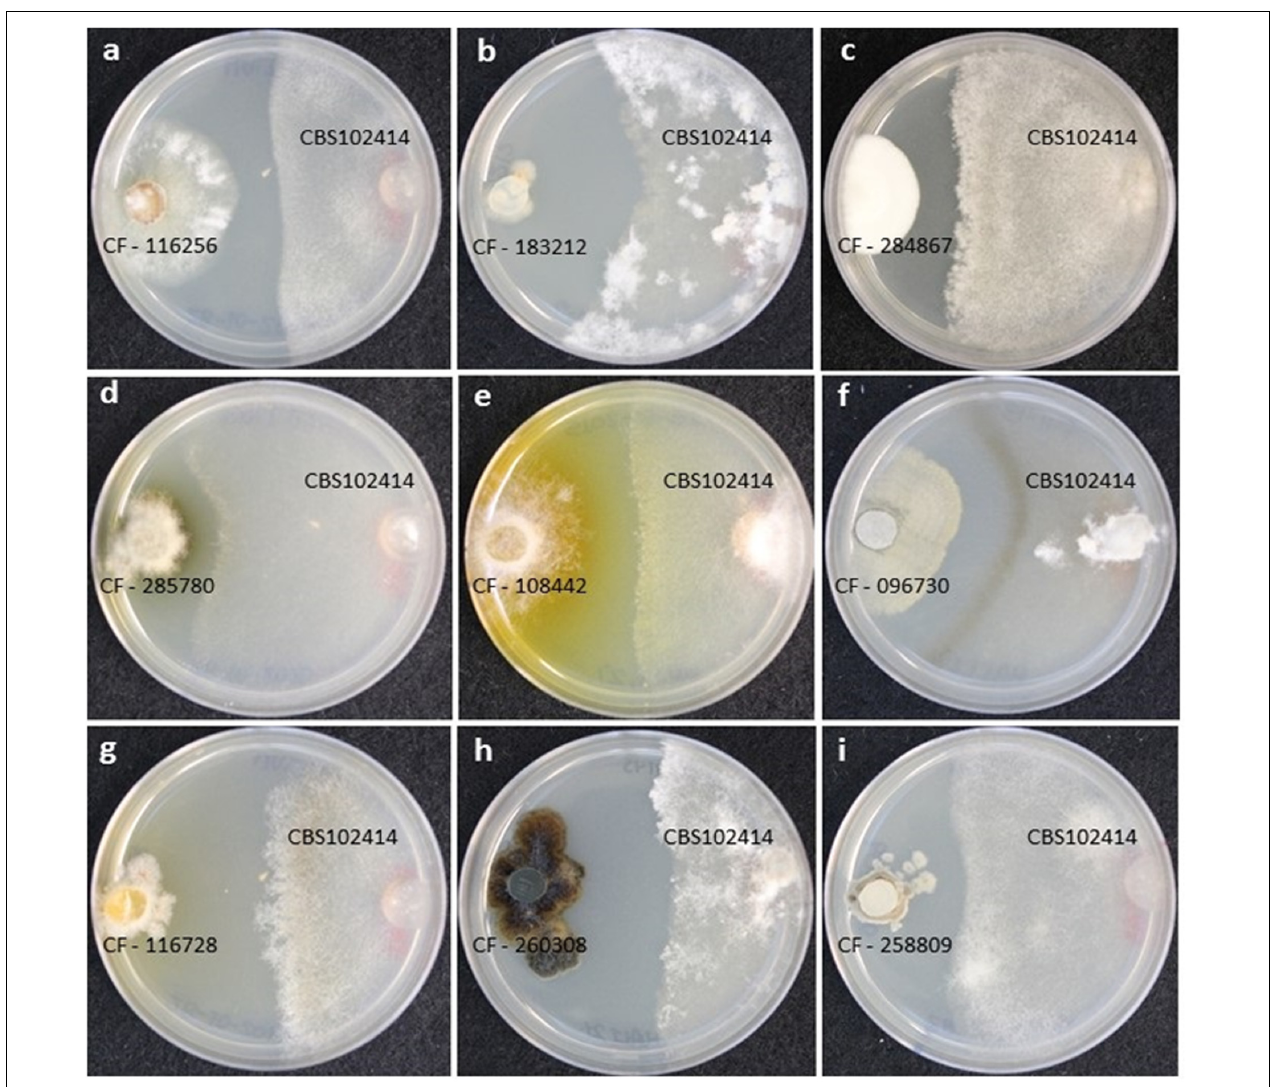
FIGURE 1 | (A–I) Different growth morphologies and colony-front patterns in Botrytis cinerea CBS102414 as a response to the microbial interaction with wild-type fungal